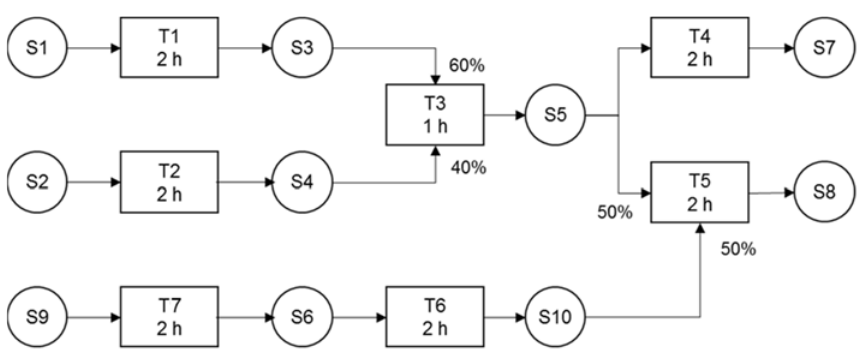
Figure 11. STN representation of the product recipe. The processing units R1, R2, R3, R4, R5, and R6 can be used for processing tasks, with units R3 and R6 being multipurpose. The raw-materials storage vessels are dedicated and have unlimited capacity. Heat storage units TES1 and TES2 can perform charge/discharge tasks C1/D1 and C2/D2, respectively. The pairs of units R1-R2, R3-TES1, R4-TES1, R5-TES2, and R6-TES2 may process heat integration using the respective heat exchanger unit H1, H3, H4, H5, and H6. Additionally, systems SOL1 and SOL2, with corresponding solar units, may be connected to units TES1 and TES2, respectively. The tasks T1, T3, and T6 operate at 80 ◦ C, 120 ◦ C, and 150 ◦ C, respectively, requiring cooling, while the tasks T2, T4, T5, and